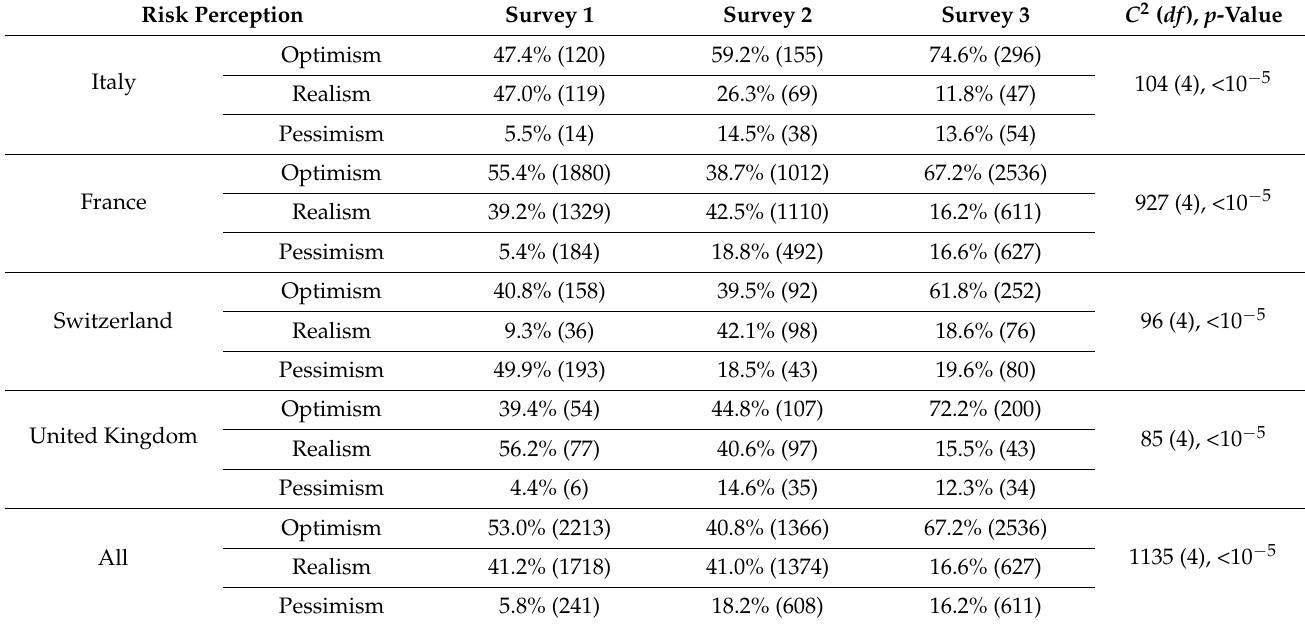
Table 2. Distribution of optimism, realism and pessimism related to SARS-CoV-2 infection across countries and epidemic